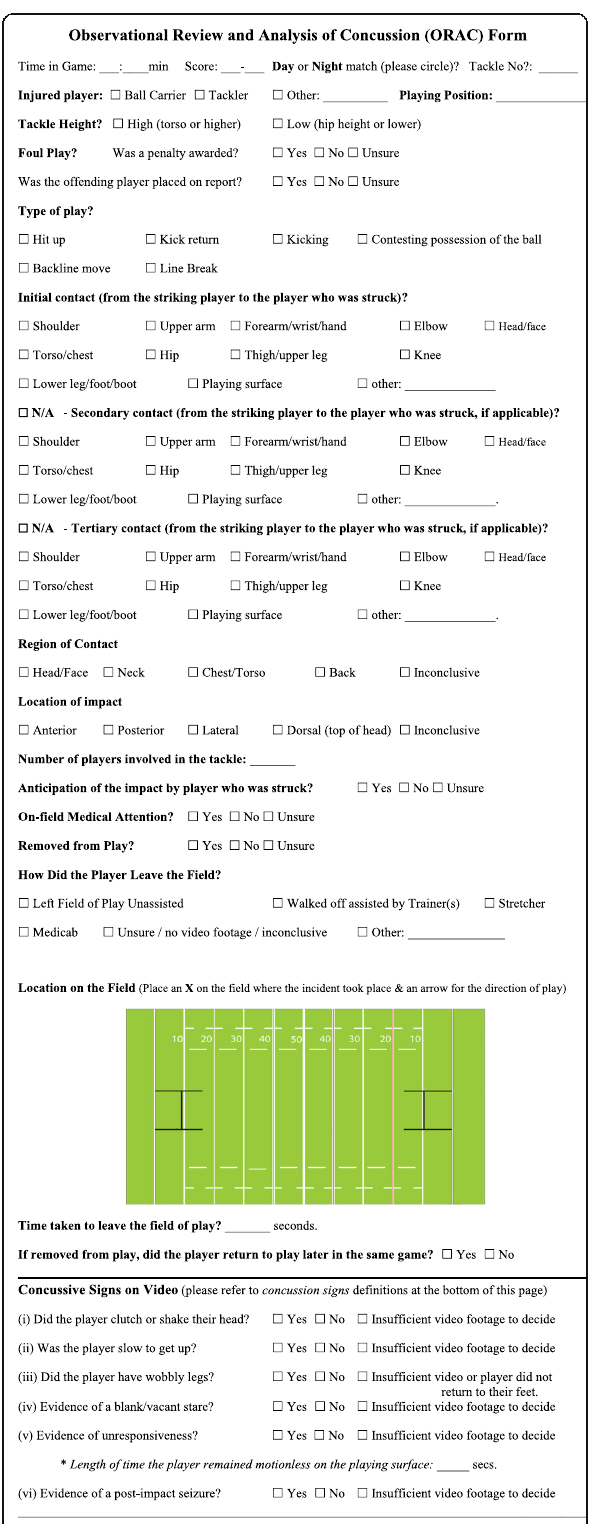
Fig. 1 The Observational Review and Analysis of Concussion (ORAC)